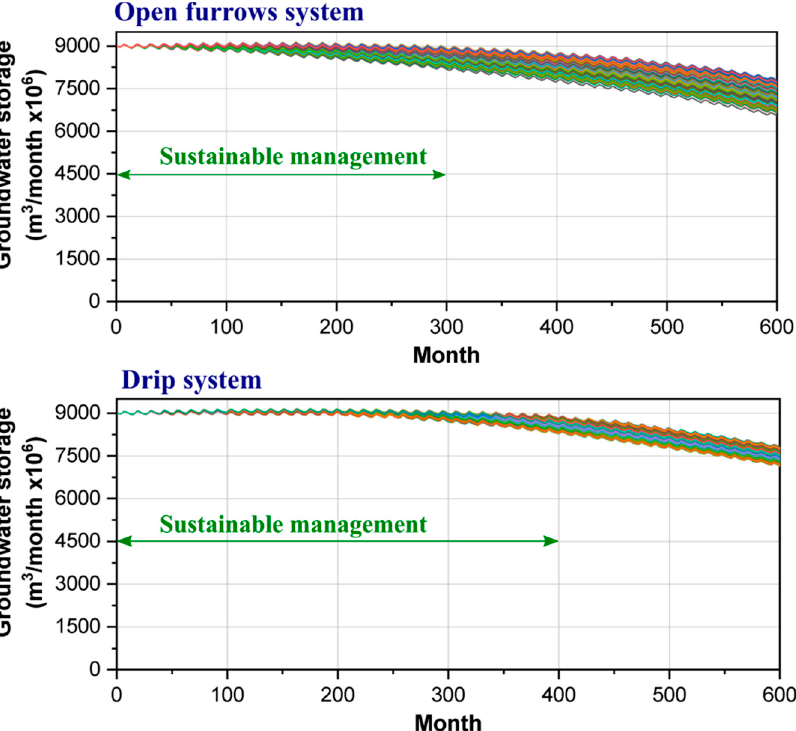
Figure 8. Illustrates the sustainable groundwater management periods achieved for 50 years for both irrigation systems using ε